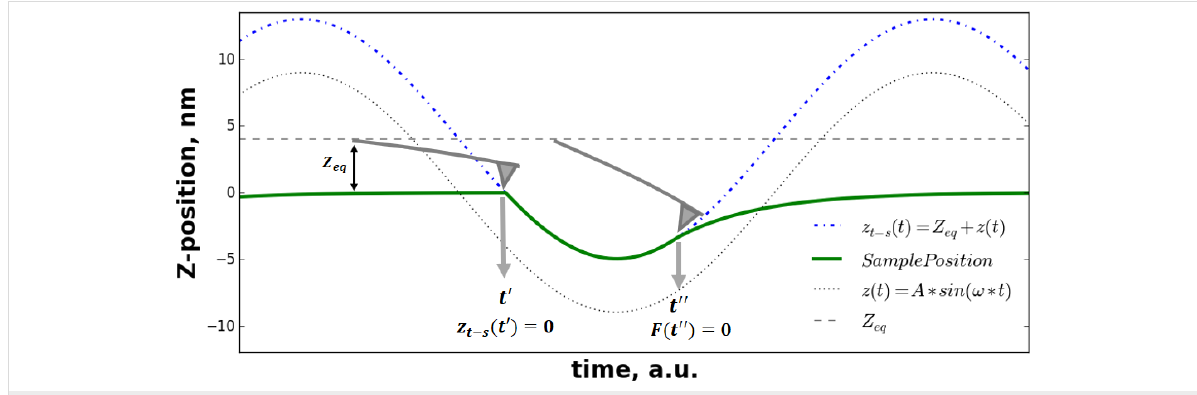
Figure 2: Scheme of intermittent-contact tip–sample interaction in AFM. The figure shows the results of a numerical simulation of a rectangular canti- lever with a flat-end tip tapping on a viscoelastic surface. The black dotted line refers to the instantaneous tip deflection. The tip trajectory (blue dash- dotted line) displays a nearly sinusoidal behavior in tapping-mode AFM, typical of high- Q environments. The green line corresponds to the sample de- formation (instantaneous sample position). The sample viscoelastic parameters have been chosen in the simulation in such a way that it undergoes a relatively large deformation. The above has been done for illustrative purposes. However in typical cases it is expected that the sample deformation will be significantly smaller than tip displacement. The green solid line represents the sample position. From time t ′ to time t ″ , tip and sample share the same spatial coordinate, which is the key observation for the derivation of the analytical equations in this study. During this time range the deforma- tion can be regarded as the excitation (see Equation 17). Using that displacement excitation, an analytical closed-form relation for the force can be derived (Equation 29). At time t ′ , the tip–sample position is zero (taking as reference the undeformed surface), and from Equation 15 it is clear that: A sin( ω t ′ ) = − Z eq . At time t ″ , the tip–sample force becomes zero, which indicates loss of contact between tip and the